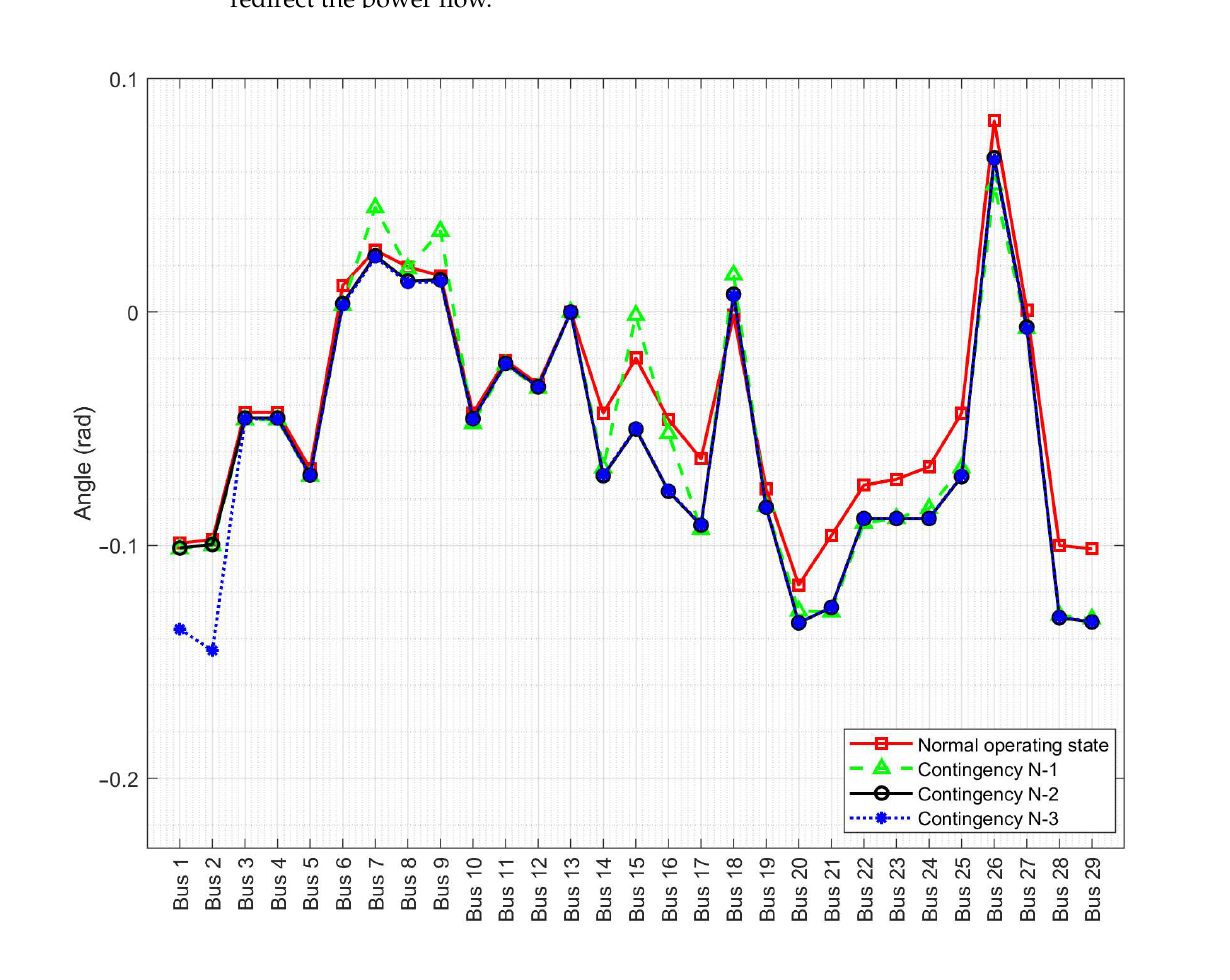
Figure 5. Angular